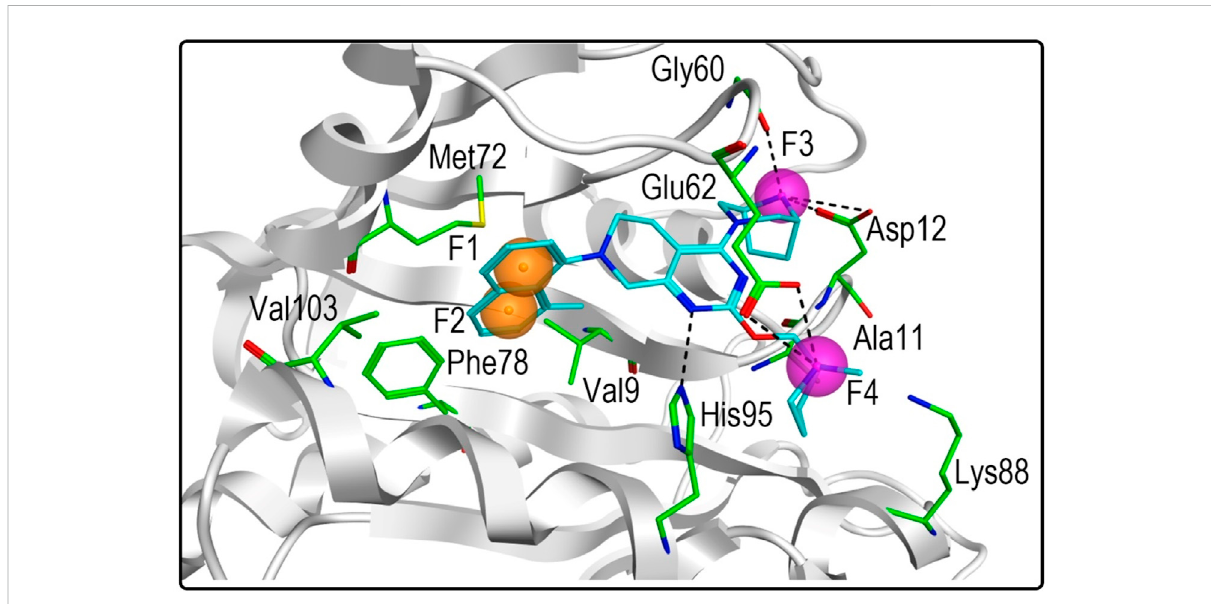
FIGURE 2 Pharmacophore model of KRAS G12D was derived from the interaction of TH-Z835 and active-site amino acids. The ligand TH-Z835 is shown as cyan stick. Orange spherescorrespond to aromaticfeatures(F1and F2:Aro), andpurplespheresrepresent hydrogen-bond donors (F3 andF4: Don). Active-site residues are shown as green sticks. Hydrogen bonds are represented by black dotted lines.